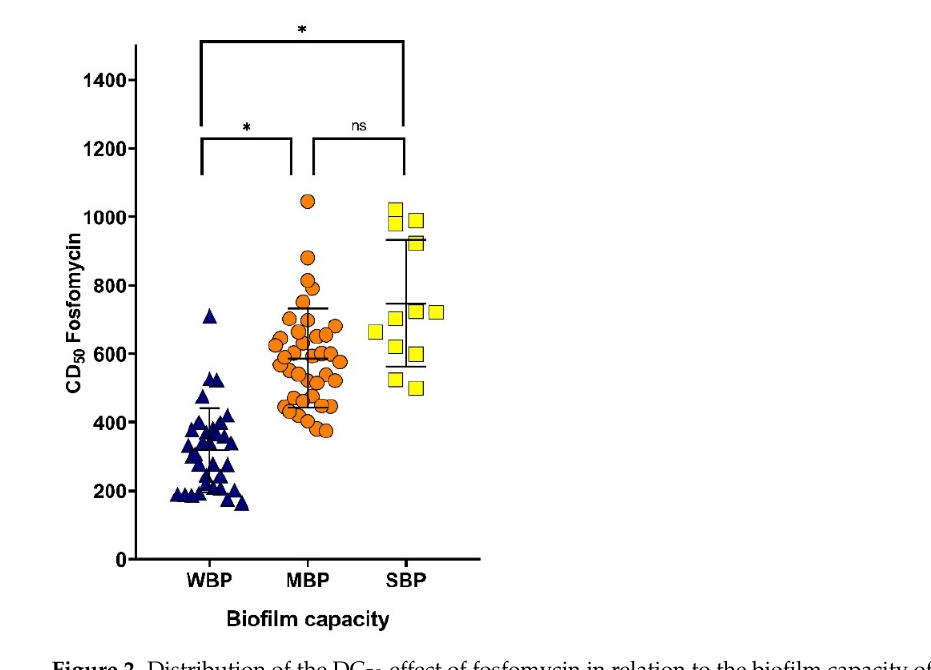
Figure 2. Distribution of the DC 50 effect of fosfomycin in relation to the biofilm capacity of the UPEC isolates. One-way ANOVA was performed, and the Tukey post hoc test was conducted to compare the concentration of fosfomycin that degraded 50% of the biofilms in the different groups of biofilm producers, where significant differences are indicated as follows: ns, not significant ( p > 0.05); * p <